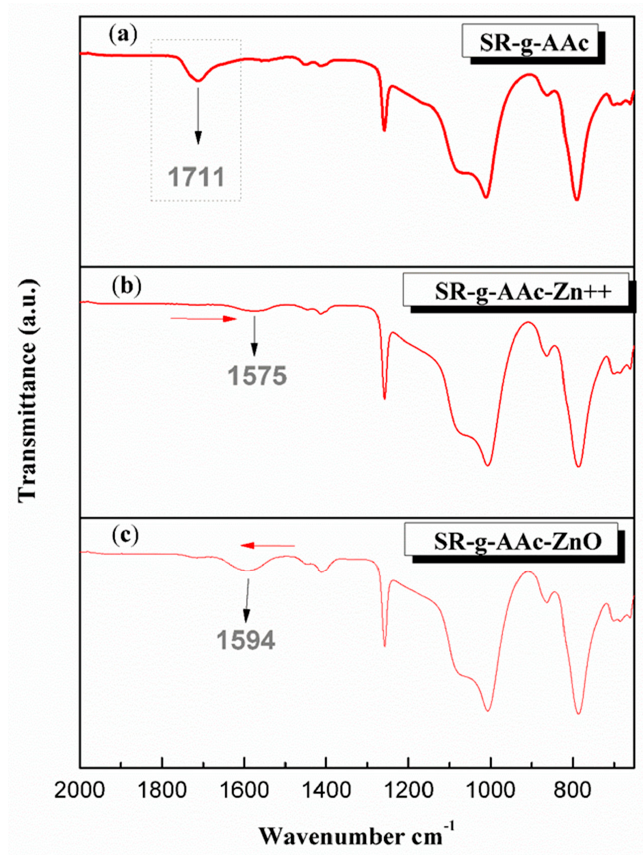
Figure 4. ( a ) FTIR of SR-g-AAc with the characteristic peak at 1711 cm − 1 corresponding to the car- bonyl of PAAc; ( b ) FTIR after soaking of SR-g-AAc in zinc acetate and shifting to a lower wavenumber of 1575 cm − 1 , ( c ) FTIR after the reduction of Zinc ions chelated to PAAc to ZnO NPs.